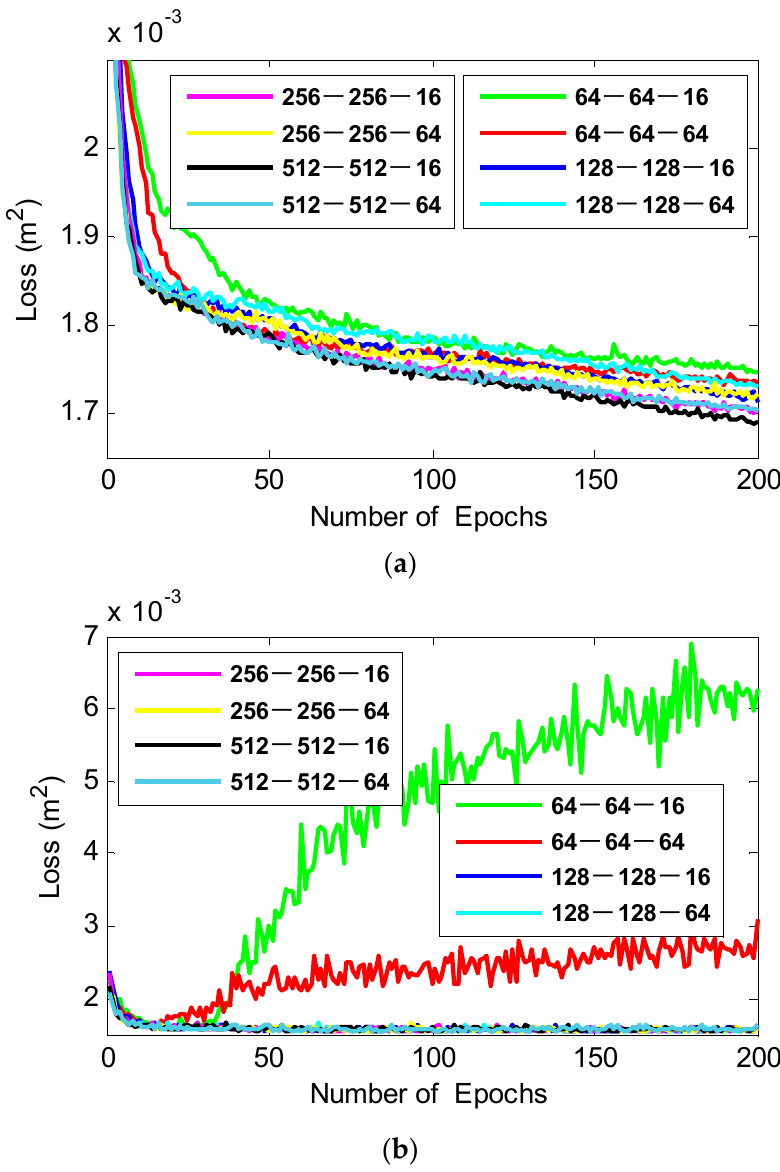
Figure 13. Variation of the training error of different neuron combinations depending on the number of epochs. ( a ) Variation of the training set error depending on the number of epochs ( b ) Variation of the test set error depending on the number of epochs.